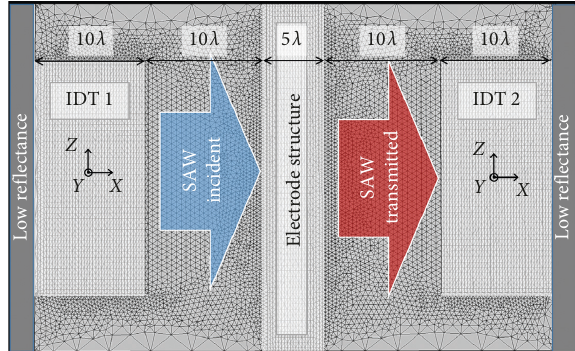
Figure 7: The configuration and structure of the model of the SAW device with the controllable electro-induced periodical